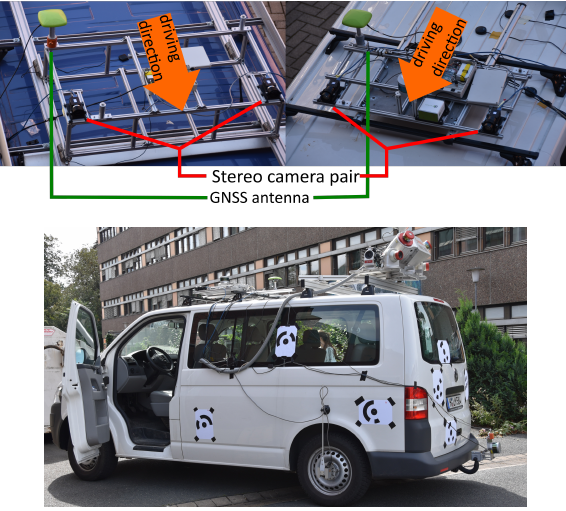
Figure 1. Top: multi-sensor platforms used for this paper. Left: platform of the trailing vehicle. Right: platform of the front vehicle. Both platforms are equipped with a GNSS receiver and a stereo camera pair looking into the direction of travel. Bottom: Front vehicle with attached